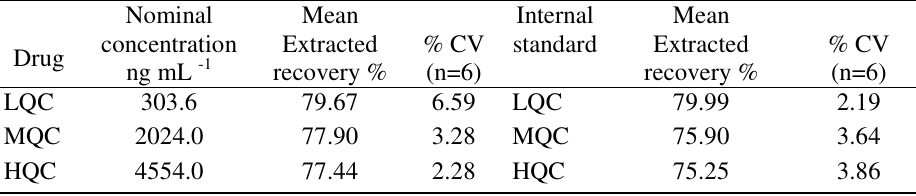
Table 4 . Extraction recovery for drug and internal